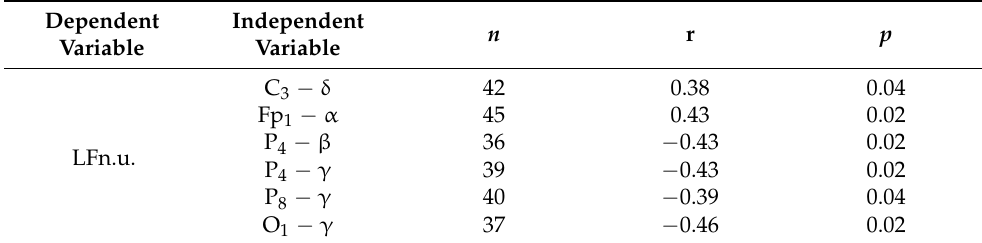
Table 3. Significant associations between electroencephalography variables and normalised low frequency heart rate variability of train